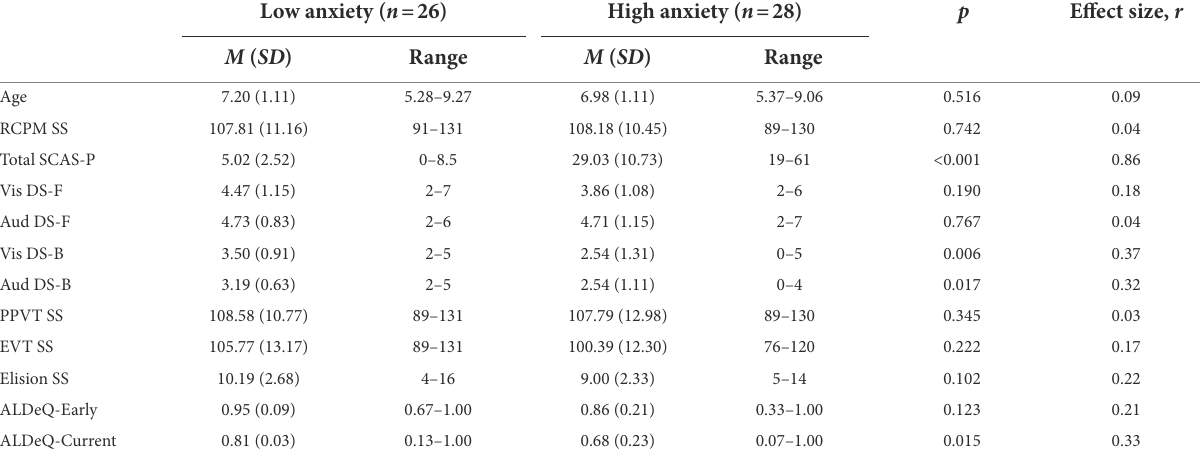
TABLE 4 Descriptive information and Mann–Whitney U test results low and high anxiety